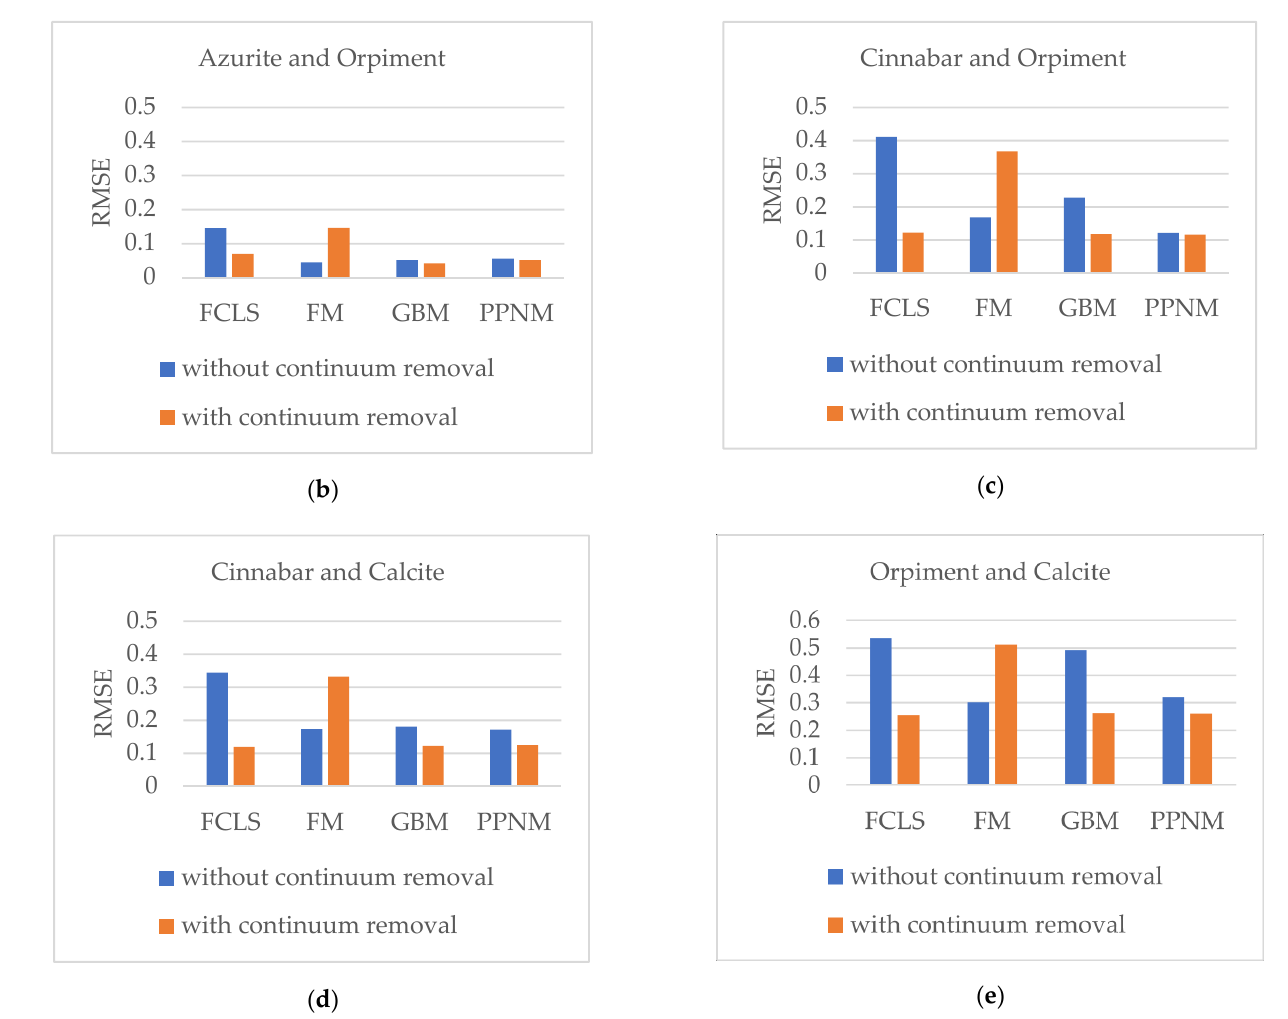
Figure 11. The comparison of the RMSE values of four algorithms in different mixtures with and without continuum removal: ( a ) azurite and malachite; ( b ) azurite and orpiment; ( c ) cinnabar and orpiment; ( d ) cinnabar and calcite; ( e ) orpiment and calcite.